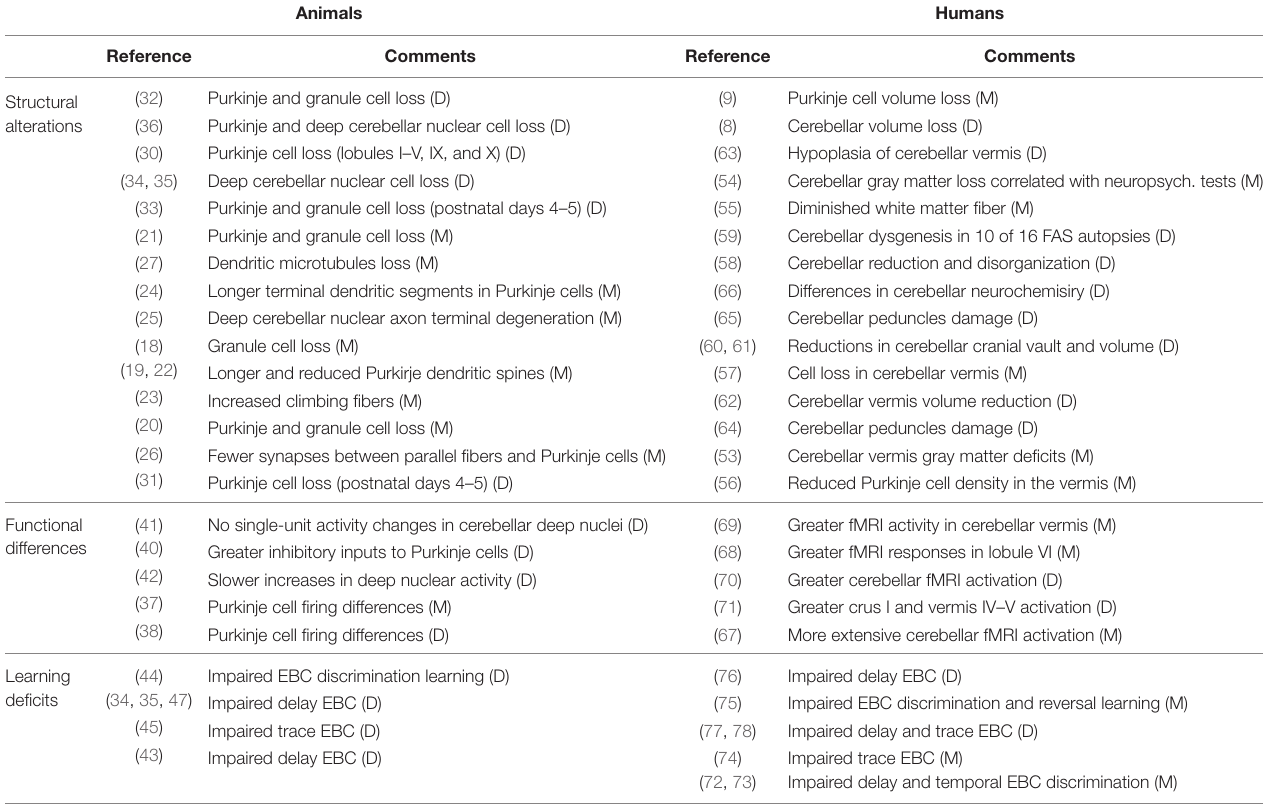
TABLe 1 | effects of alcohol on cerebellar structure, function, and eyeblink conditioning reported in the literature.